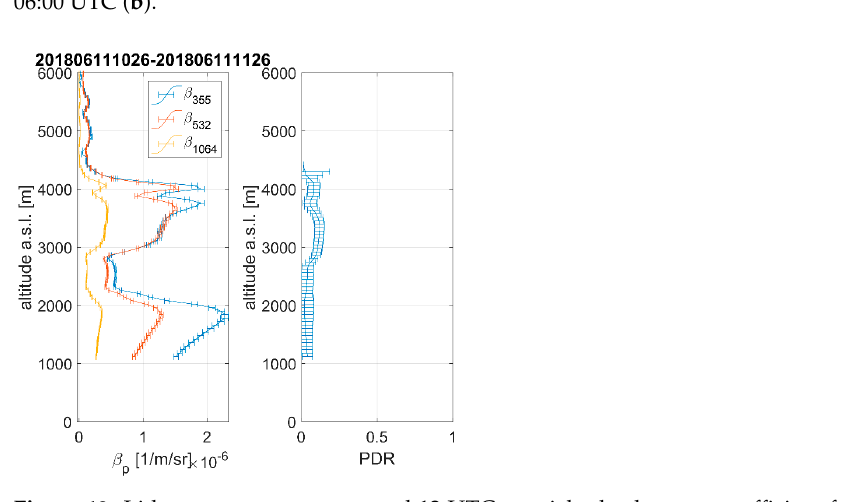
Figure 12. Air mass back-trajectory for layers at ~4200 m, with staring times at 05:00 UTC ( a ) and 06:00 UTC ( b ).